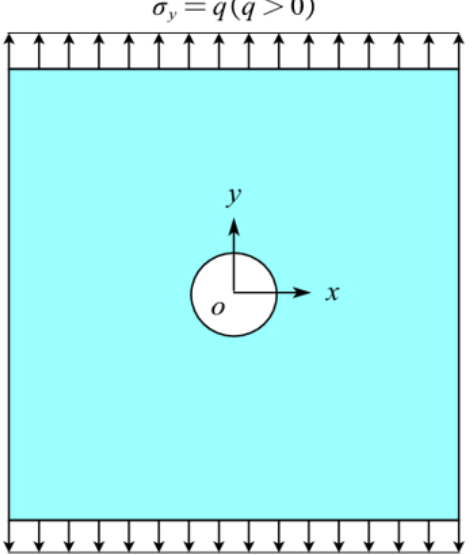
( d ) Figure 17. The distribution of displacement when the plate bending: ( a ) u x calculated by original PD; ( b ) u y calculated by original PD; ( c ) u x calculated by Equation (7); ( d ) u y calculated by Equation (7).